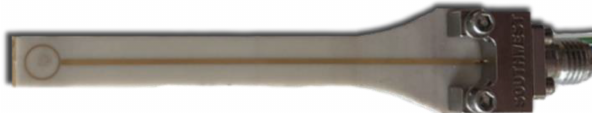
Figure 6. Top view of the optimized sensor